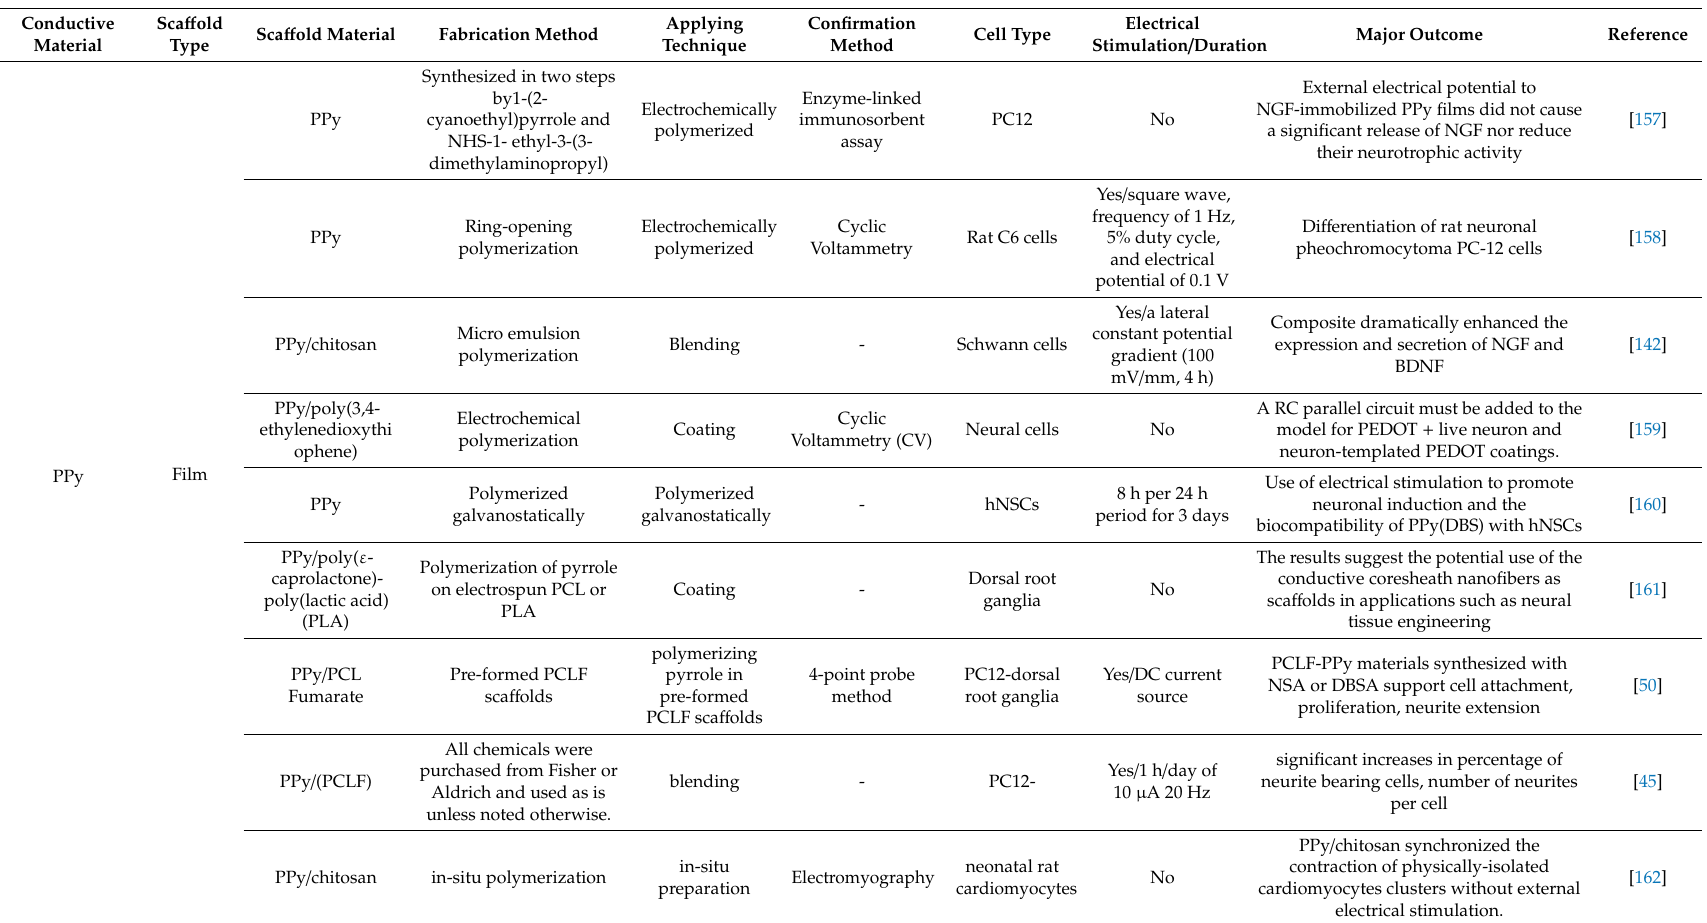
Table 2. Conductive sca ff olds used in neural tissue